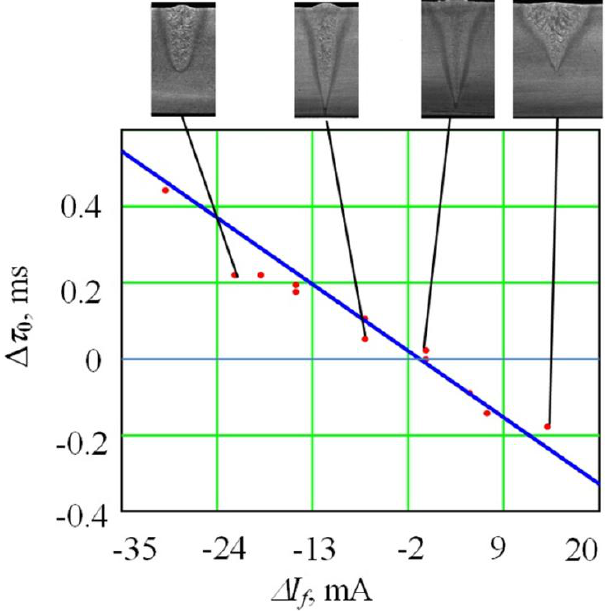
(delay of function S (  ) concerning signal in 0 . Steel welding with the oscillation along the f